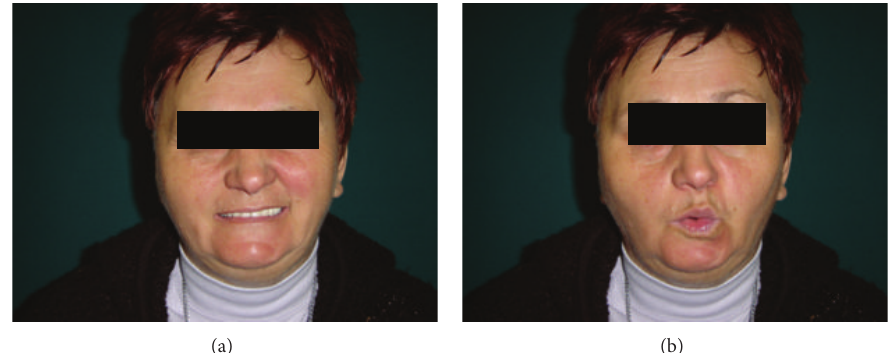
Figure 1: Eight days following stapedotomy, House-Brackmann grade II facial palsy is observed on the right side: teeth showing (a) and lip rounding (b).